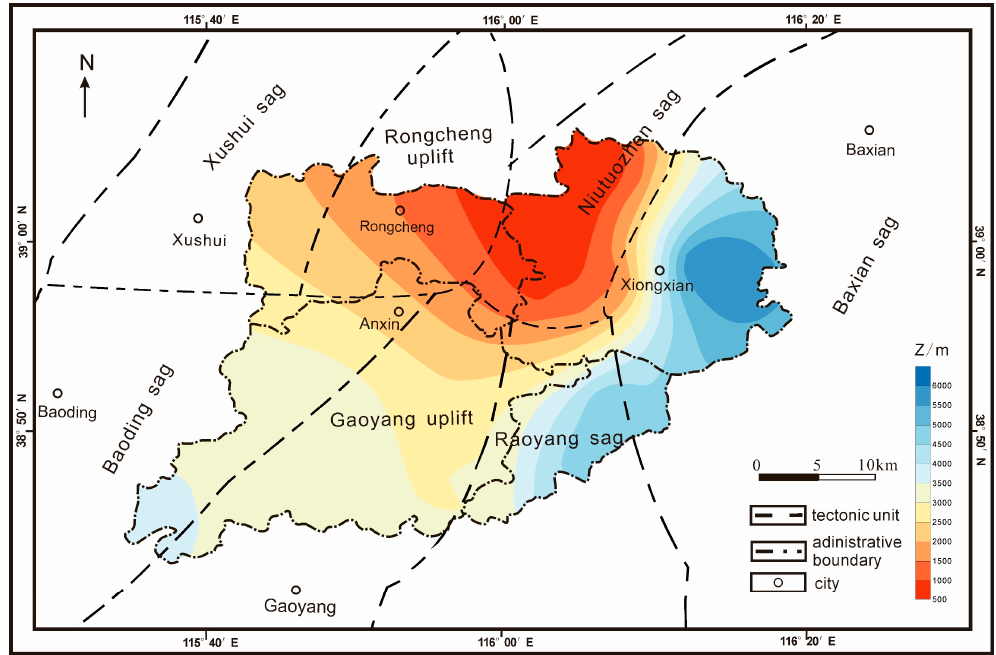
Figure 8. Top depth of the Jxw Formation in the Xiong’an New Area.